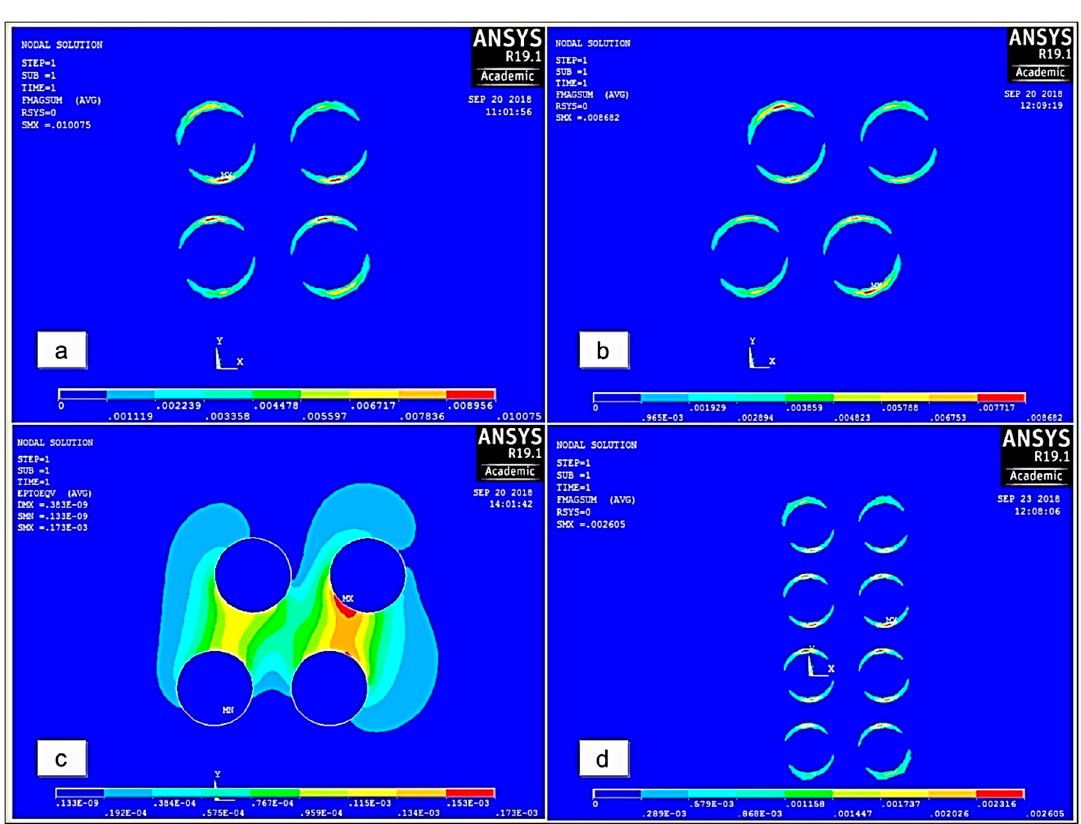
Figure 16. The magnetic force produced on IPs in ( a ) unconstrained and ( b ) constrained conditions; ( c ) mechanical strain on IPs under strained conditions; ( d ) effect of an increase in thickness on the magnetic force of particles [31] (reprinted with permission from Elsevier TM ).